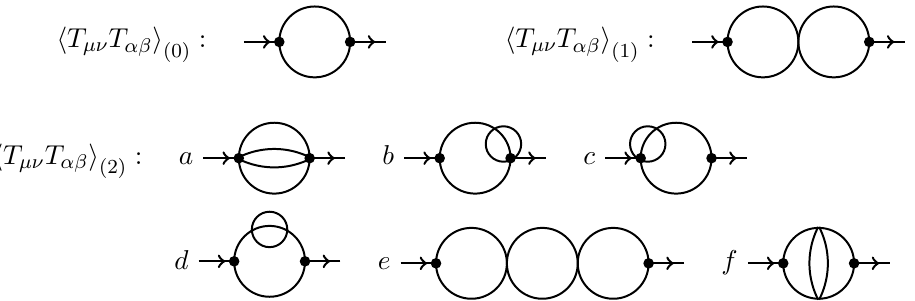
Figure 1 . Diagrams for the 2-point function. The thick dot represents a stress tensor insertion. The left one has indices µν ; the right one αβ . The arrow represents the flow of the external momentum p